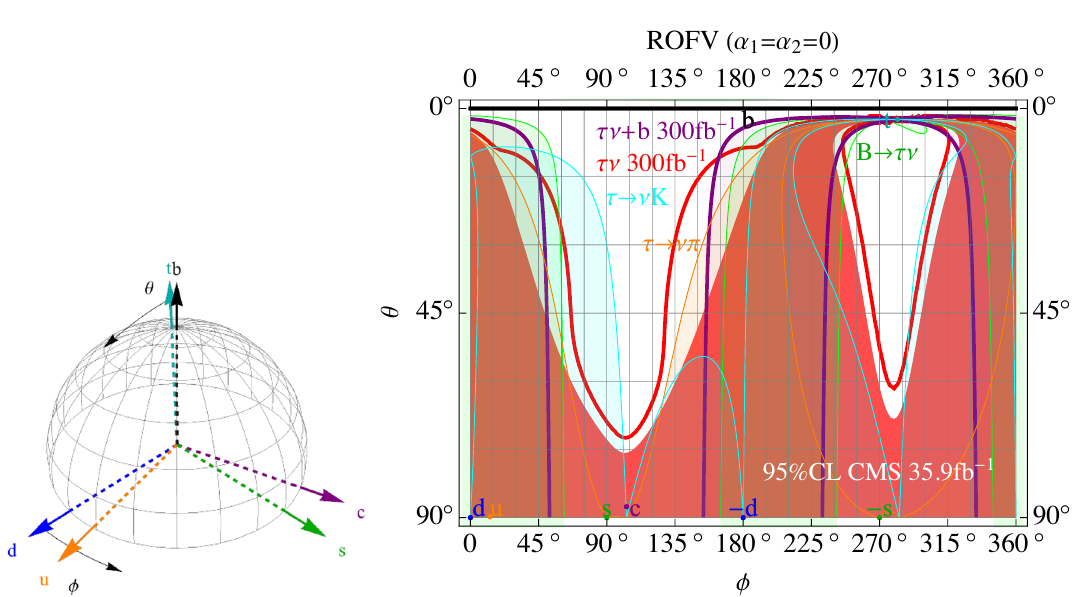
Figure 10 . Under the ROFV assumption (for α 1 = α 2 = 0 ), we show with a red-coloured region the 95% CL exclusion from the CMS pp → τν search, assuming that the best-fit value of R ( D ( ∗ ) ) is reproduced. The red and purple lines correspond to the expected 95% CL limits with 300 fb − 1 from pp → τν and pp → τνb , respectively. We also report the 95% CL limits from B → τν (green), τ → νK (cyan), and τ → νπ